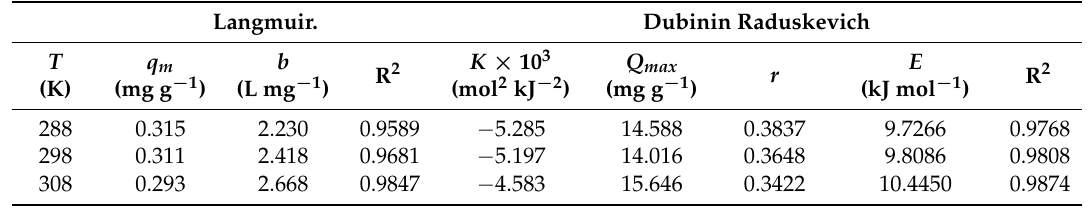
Table 1. Langmuir and DR isotherms for As (III) adsorption on Fe-modified W zeolite. Table 1 . Langmuir and DR isotherms for As (III) adsorption on Fe-modified W zeolite . Langmuir .